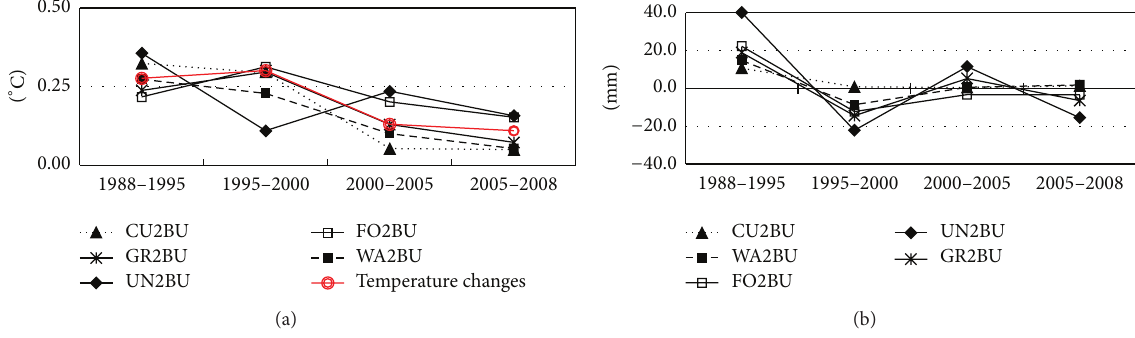
Figure 9: Changes of temperature (a) and precipitation (b) upon land-use conversions from non-built-up to built-up